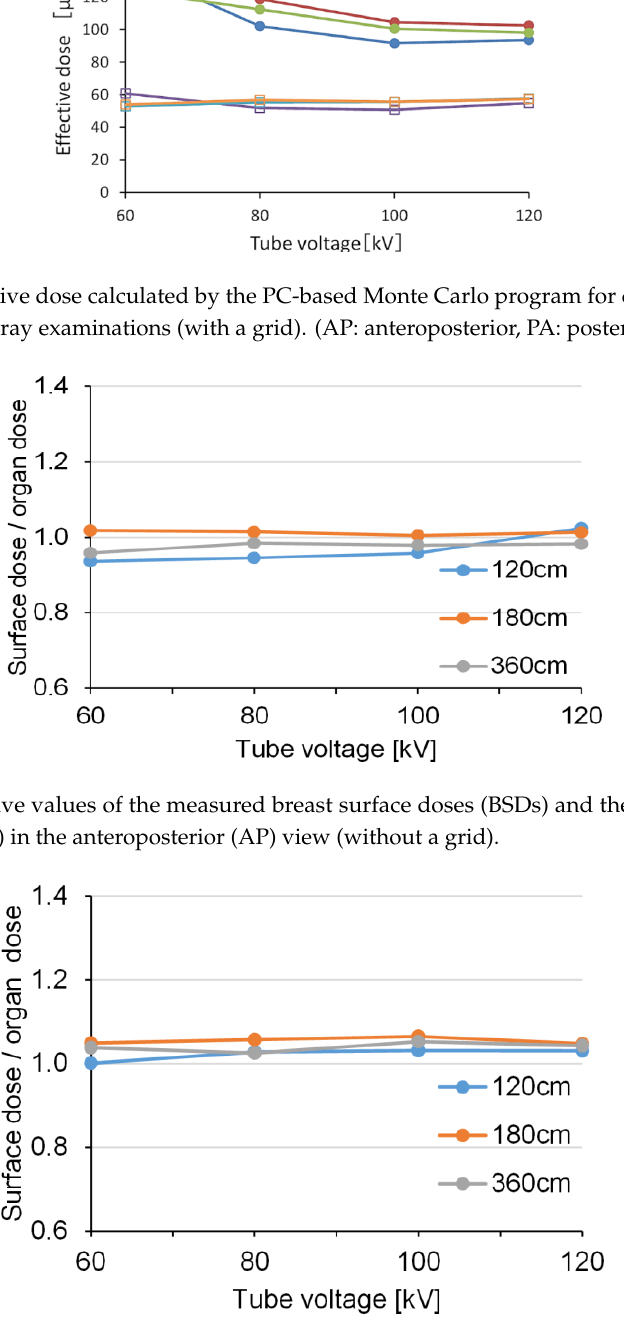
Figure 7. The relative values of the measured breast surface doses (BSDs) and the calculated breast organ doses (BODs) in the anteroposterior (AP) view (with a grid).